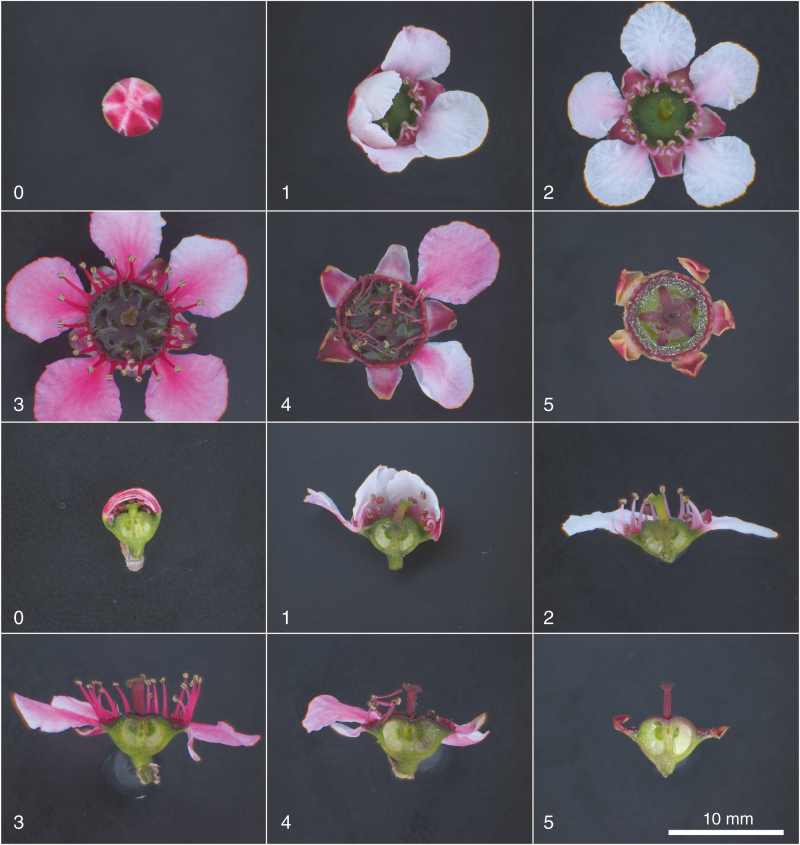
Stages of mānuka flower development in plan (above) and half flower view (below), for the MI genotype, from flower opening until sepal fall. Numbers correspond to the floral stages defined in Box 1.